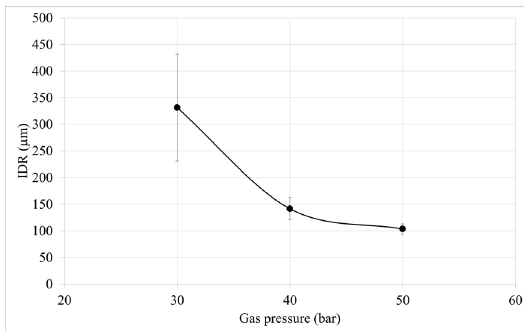
Figure 9. Atomization gas pressure influence on the Inter Decile Range